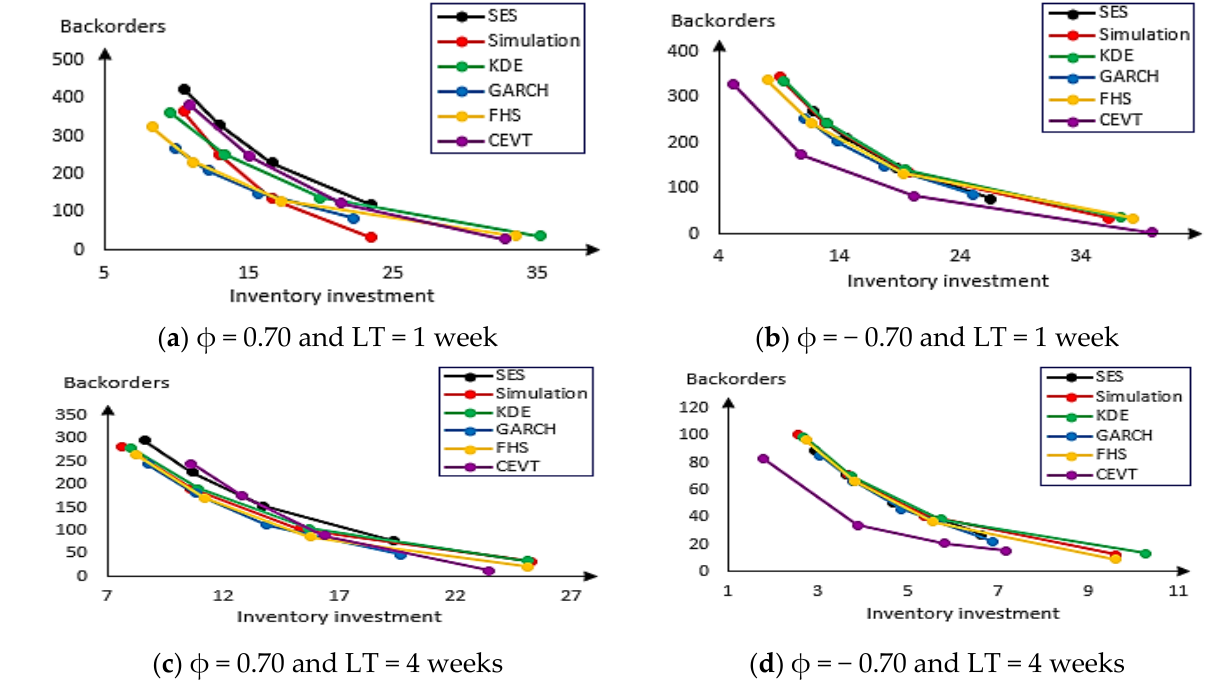
Figure 8. Tradeoff curves for AR (1) in the case of gamma distribution for φ = 0.70 ( a , c ) and φ = − 0.70 ( b , d ) and lead times of one week ( a , b ) and four weeks ( c , d ). Figure 7 plotted the backorders versus inventory investment. Each curve for each panel contained four specific points corresponding to the four targets CSL (85%, 90%,